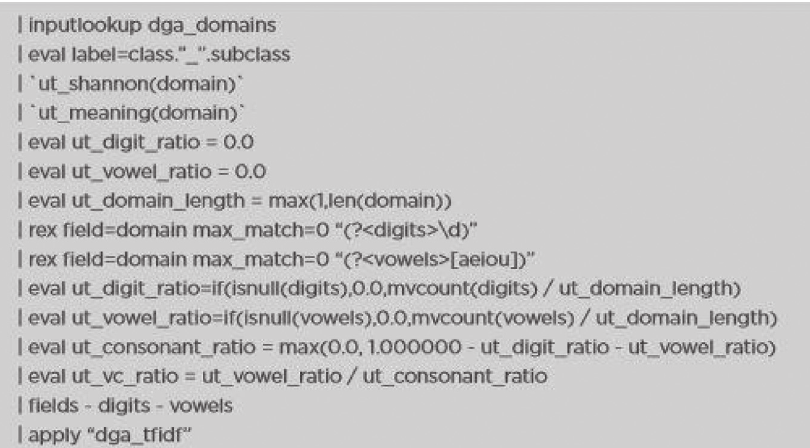
Figure 6: Analyze DNS data with SPL language related to feature calculation.